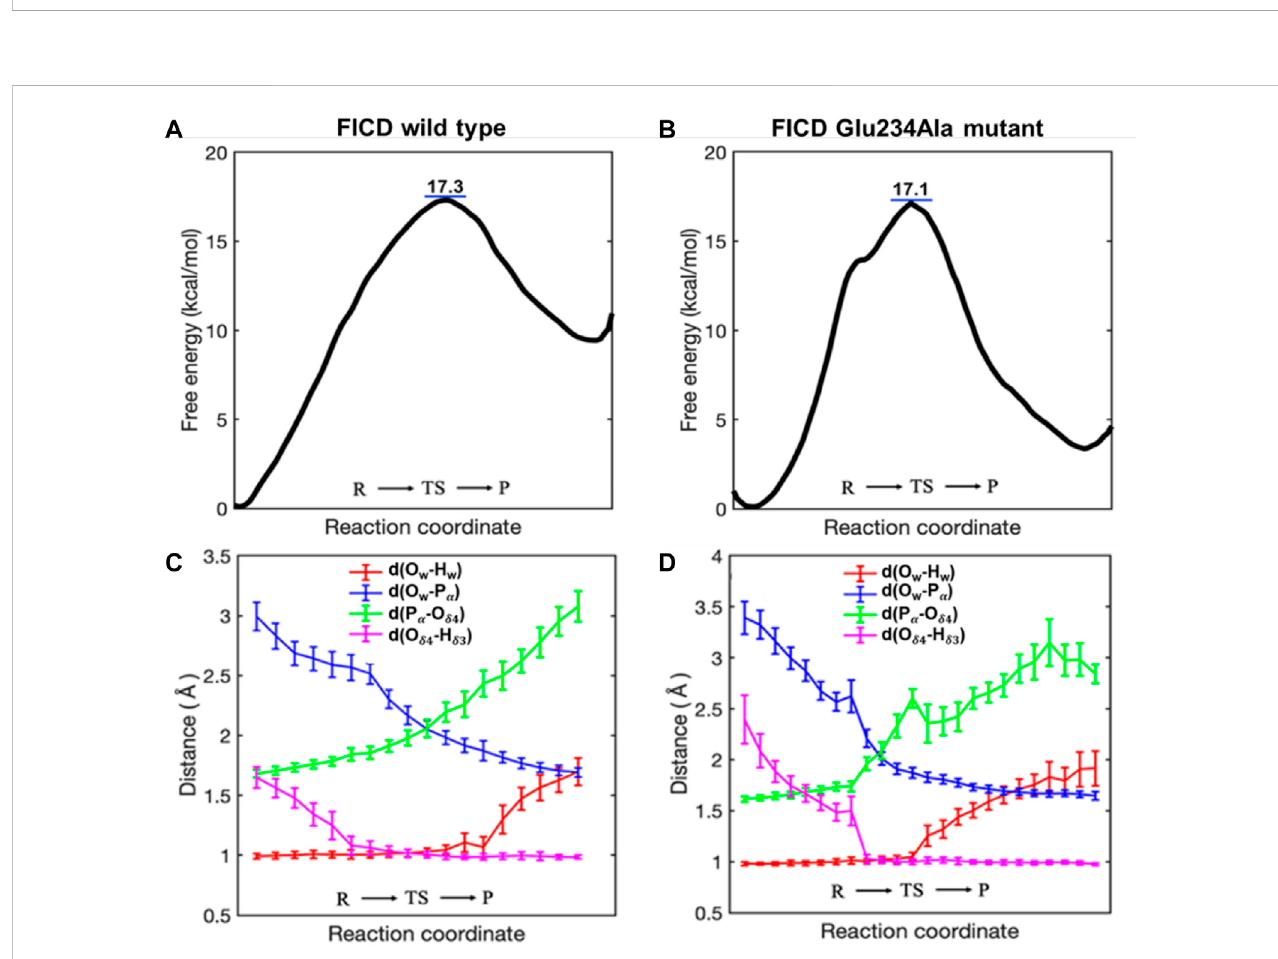
Free energy pro fi les (A, B) and pivotal distance changes (C, D) along the reaction coordinate (RC) of the deAMPylation process in the wild type and Glu234Ala mutant system.